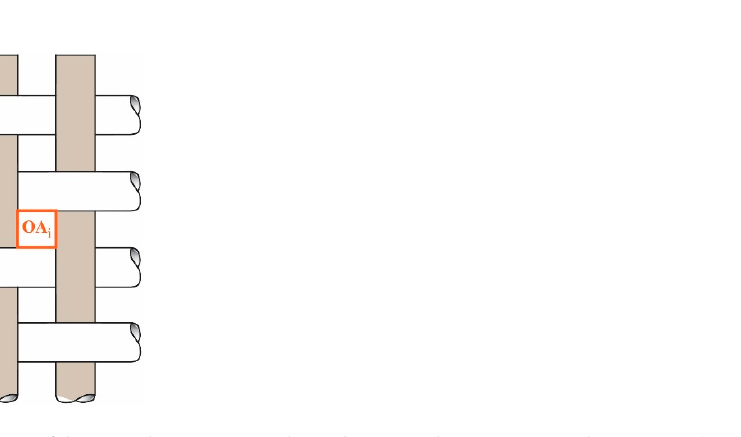
Figure 1. Scheme of woven fabric in plane weave, where there are shown areas without yarns (open area (OA) = ∑ OA i ), units/areas of fabric surface covered by only one (Cf 1 = ∑ Cf i1 ) and two yarn (Cf 2 = ∑ Cf i2 ) where i is the number of individual areas in a unit area of fabric. Generally, the theory of woven fabrics construction is defining a cover factor as a fraction of surface covered by yarns which is equal to quotient of area covered by yarns and total area of web [22] expressed by Equation (1). That way, it takes the values from 0 to 1, and if it is multiplied by 100, it is expressed in %.